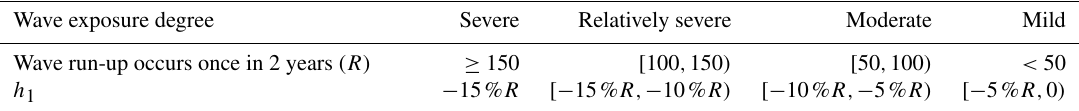
Table 4. h 1 value (unit: cm).